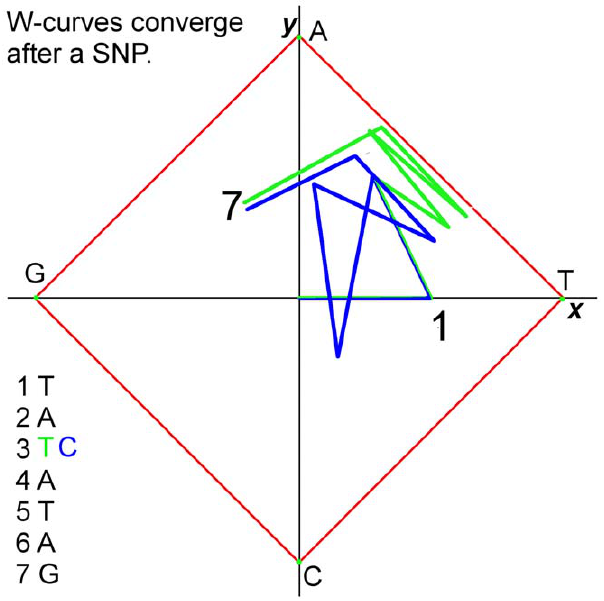
Figure 2. Autoregression characteristics of the W-curve. Two sequences are shown, one in green one in blue. The sequences differ at base 3, which causes the curves to diverge. They converge again by base number